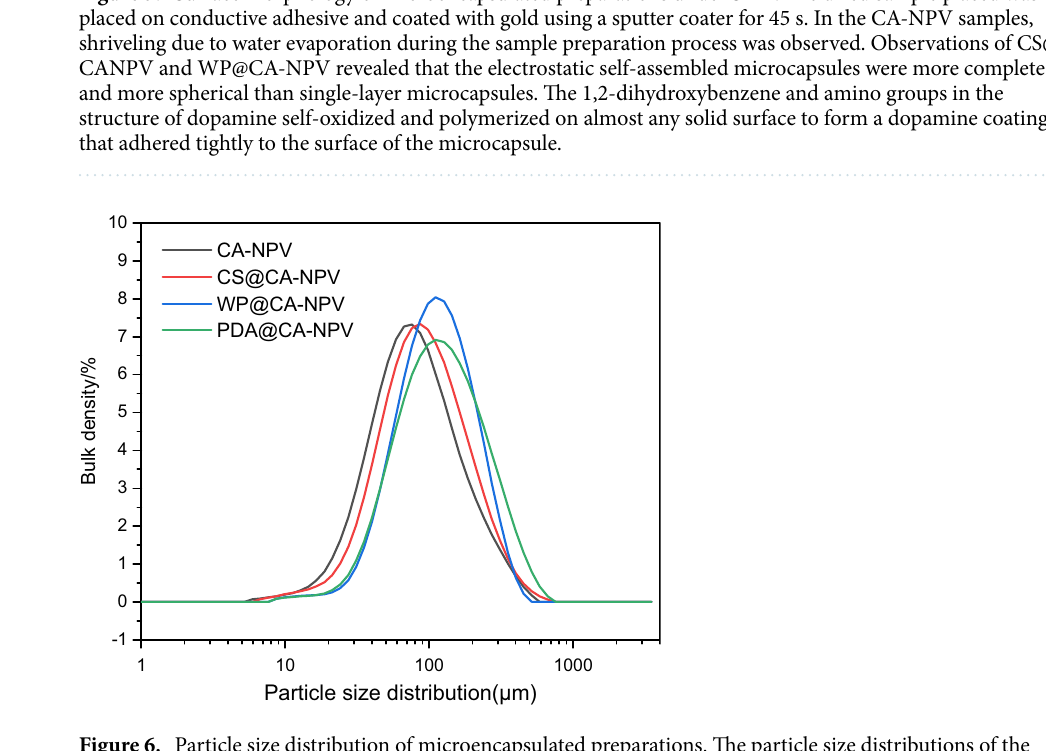
Figure 6. Particle size distribution of microencapsulated preparations. The particle size distributions of the samples were measured by laser diffraction. The corresponding diameters of 90% (DV(90)) were 215 μm, 236 μm, 252 μm and 313 μm,